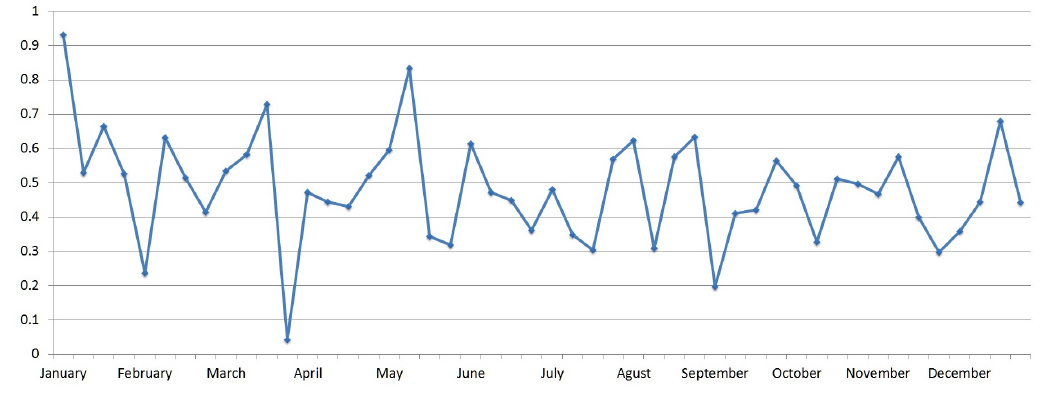
Figure 10. Near-weekly prediction precision.